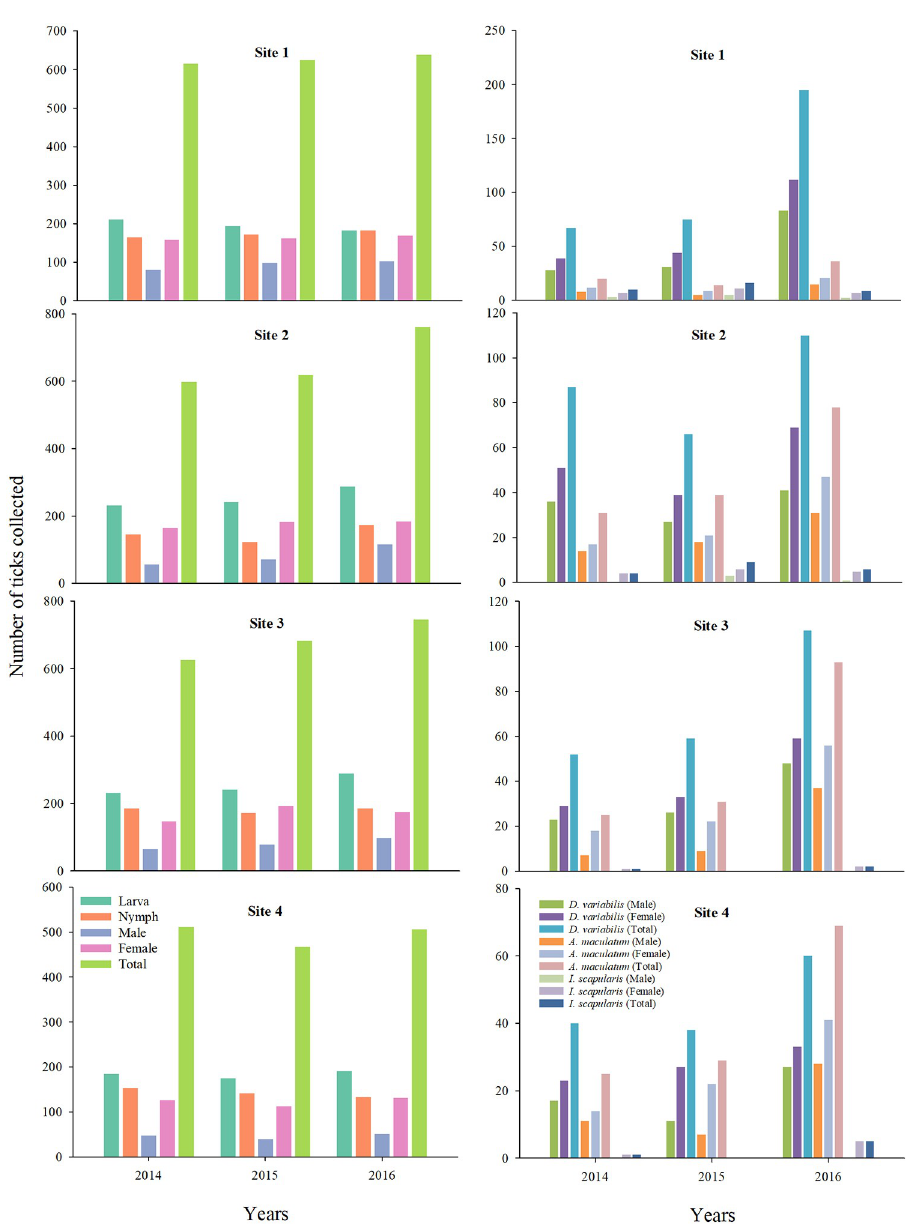
Fig 2. Tick diversity and composition observed in four seasonal sites around Pittsburg, Kansas between years 2014–2017. Plots in the left panel depict the number of three post-emergent stages and sexes of Amblyomma americanum collected, and plots in the right panel depict the number of male and female sexes of D . variabilis , A . maculatum , and I . scapularis